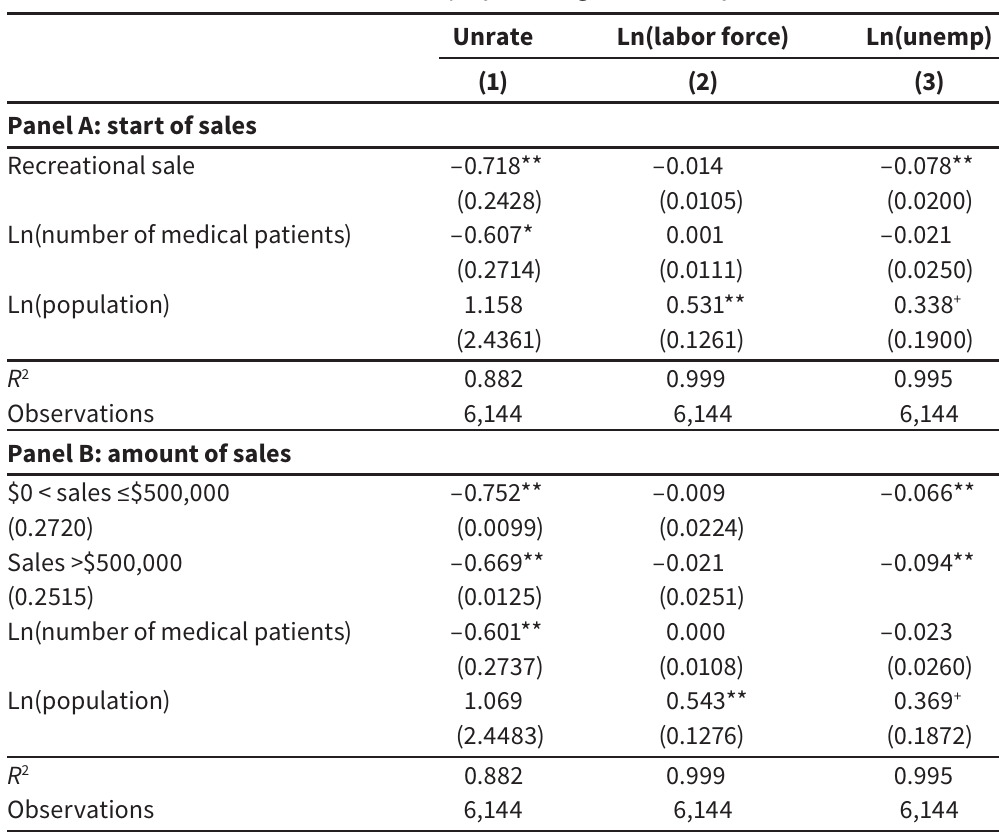
The effect of recreational dispensary entry and sales on the unemployment rate, Ln(labor force), and Ln(unemployed) – regression analysis Unrate Ln(labor